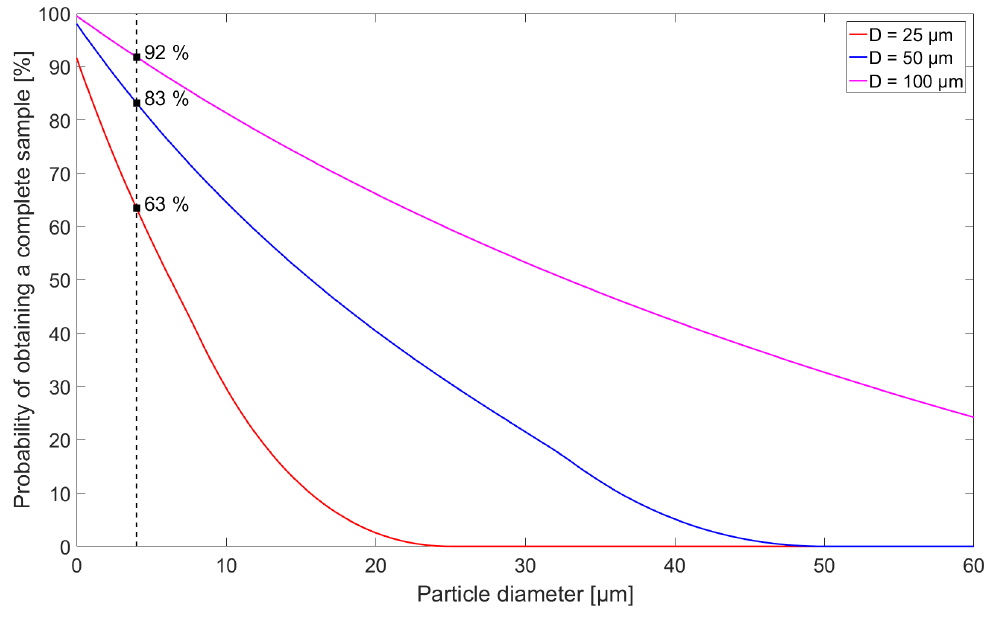
Figure 3. Theoretical curves for the probability of obtaining a complete sample for three detector aperture diameters ( D = 25, 50 and 100 µm) as a function of particle diameter. The probability of obtaining a complete sample when d = 4µm (dashed line) is displayed in the plot for the three different aperture sizes, since it constitutes the current lower detection limit of optical particle counters